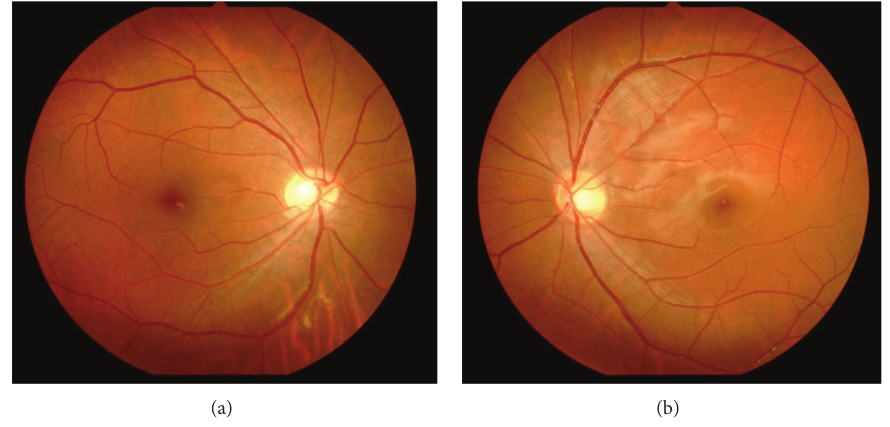
Figure 1: Right (a) and left (b) fundus photographs showing no abnormalities.